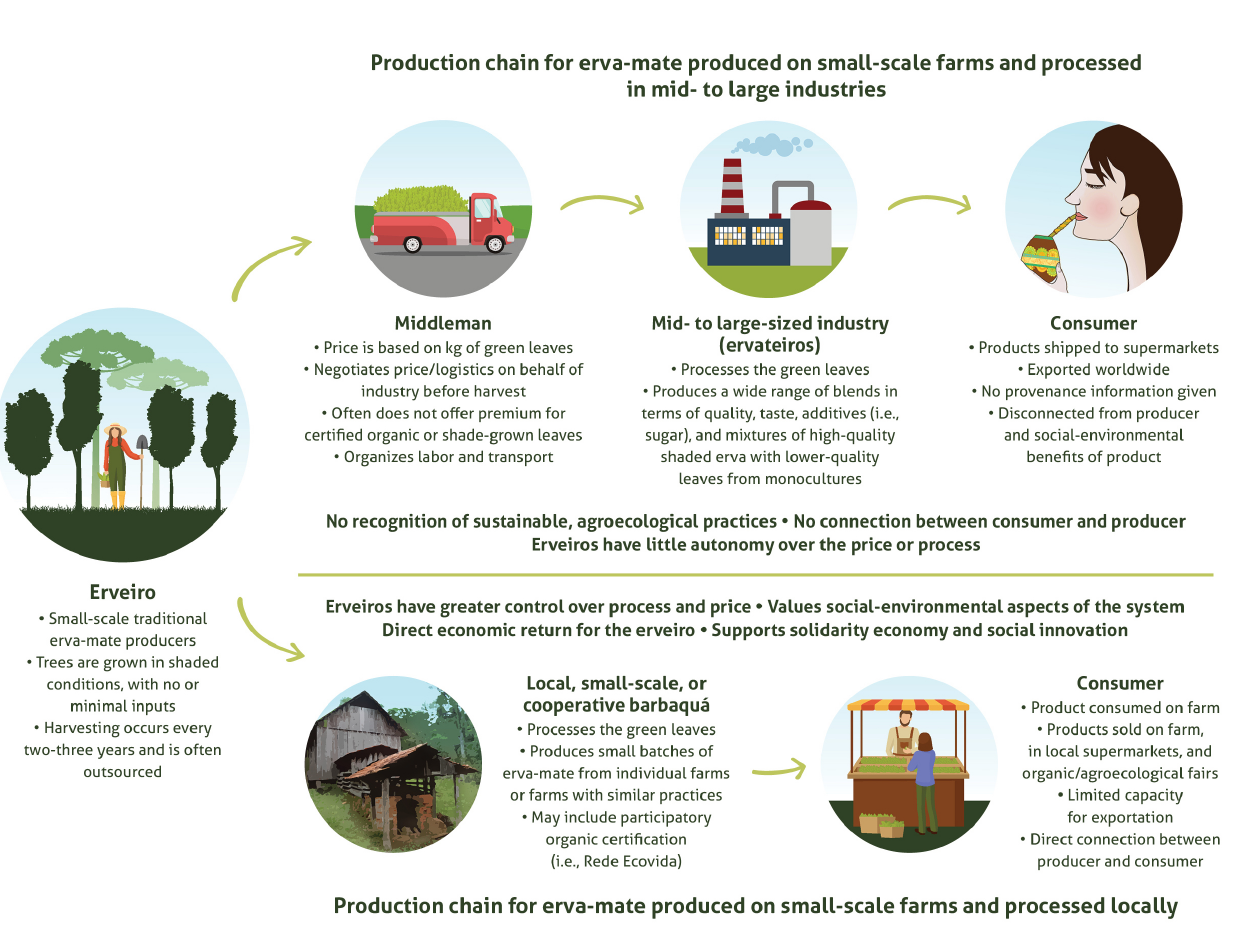
Fig. 2 . Typical production chain for erva-mate produced on small-scale, traditional farms. The cycle at the top represents processing of erva-mate through an ervateiro , or mid- to large-sized industry, usually negotiated through a middleman. The chain at the bottom represents processing of erva-mate locally in small or communal barbaquás (the infrastructure used to dry and process erva-mate in traditional systems), offering more autonomy for erveiros . Small-scale traditional erva-mate producers refer to themselves as erveiros, whereas those who run businesses and produce the finished product are referred to as ervateiros, with an implicit class